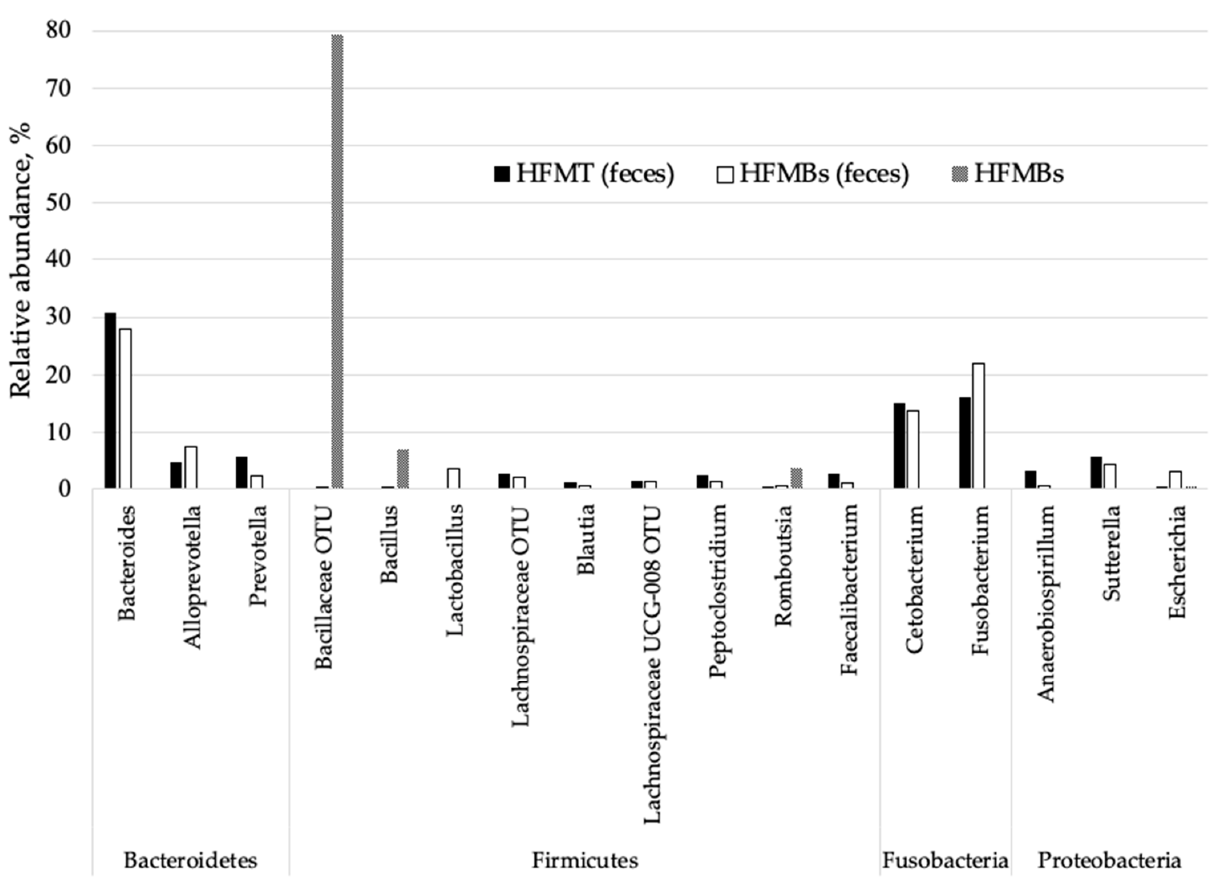
Figure 4. Relative abundance (%) of bacterial genus present in fecal microbiota of dogs consuming diet containing 9.09% Bacillus subtilis hydrolyzed feather meal (HFMBs), 9.09% thermally hydrolyzed feather meal (HFMT), and pure Bacillus subtilis hydrolyzed feather meal (HFMBs). Genus showed in the figure represents more than 90% of bacteria identified.